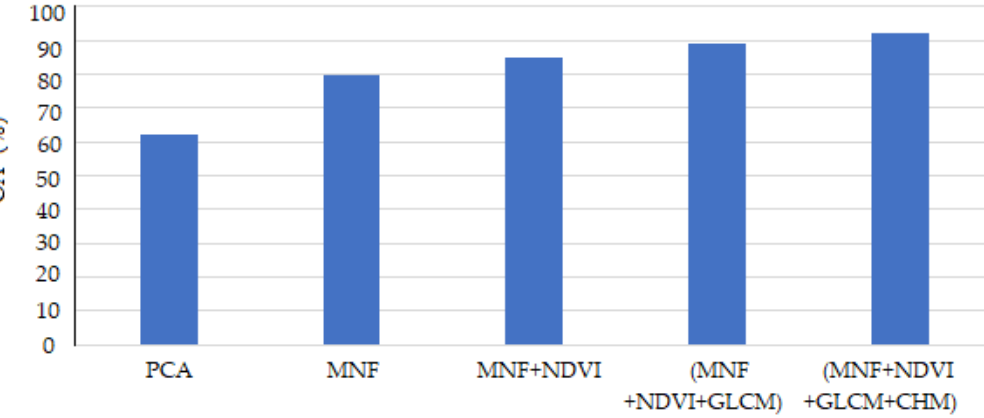
Figure 10. The overall ground object classification accuracy for different feature fusion methods.